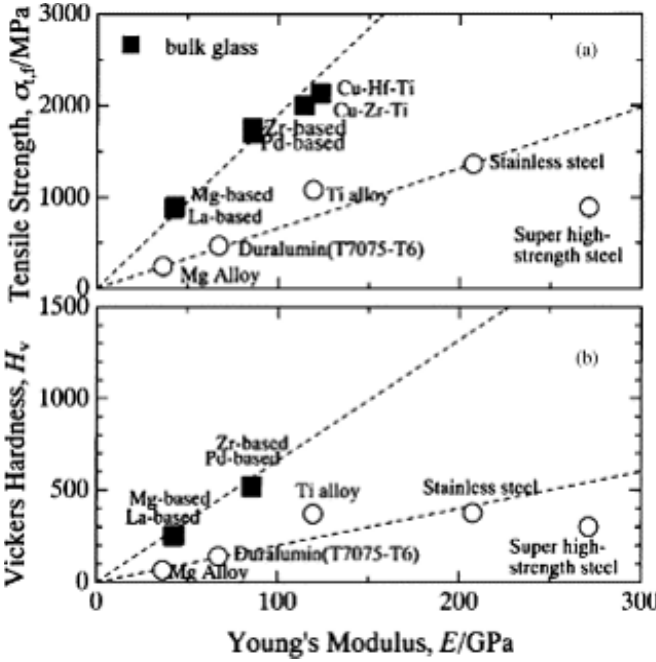
Figure 9. The relations between mechanical properties of typical BMGs: ( a ) tensile fracture strength σ t,f with Young’s modulus E ; ( b ) Vickers hardness H v with Young’s modulus E . Reproduced with permission from [144]. Copyright 2002, The Japan Institute of Metals and Materials.